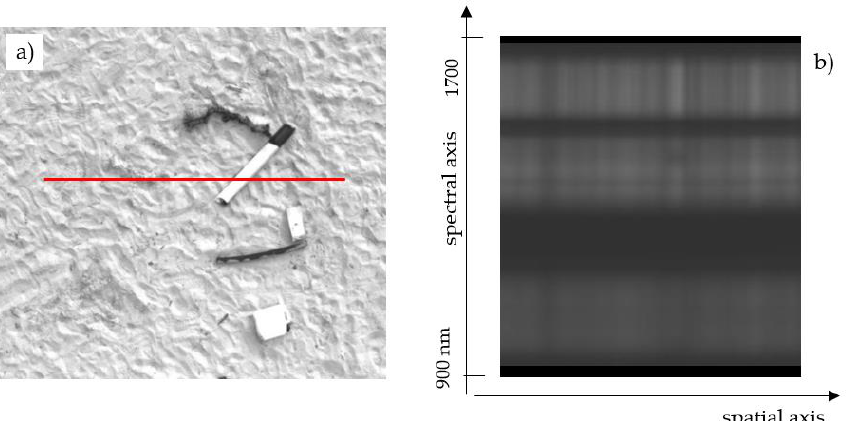
Figure 4. ( a ) Sample image acquired with the mosaicking camera; ( b ) simultaneous image acquired with the spectrometer camera, containing the spatial/spectral info of the line image drawn in red over the visible image.